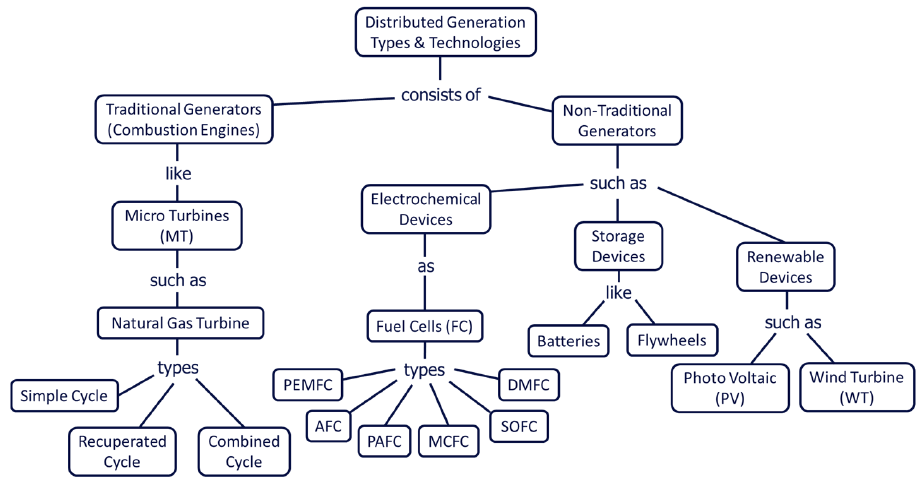
Figure 2. Distributed generation types and technologies [8].